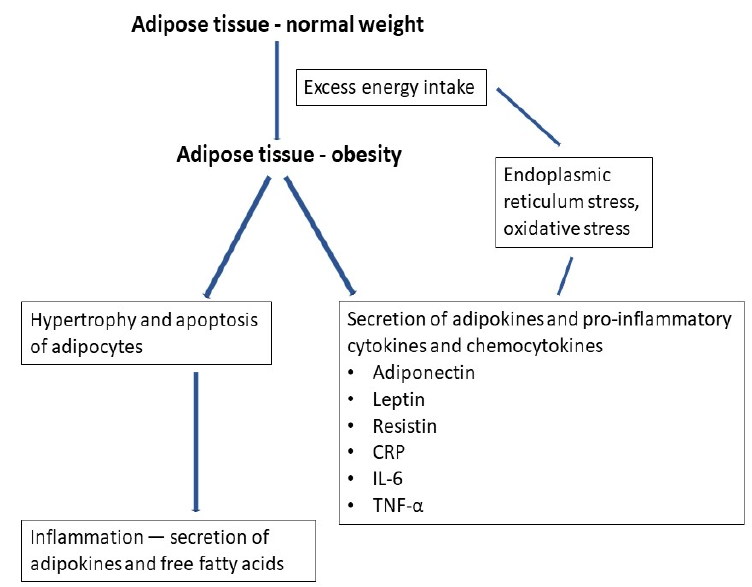
Figure 1. Mechanism of low-grade inflammation in obesity.